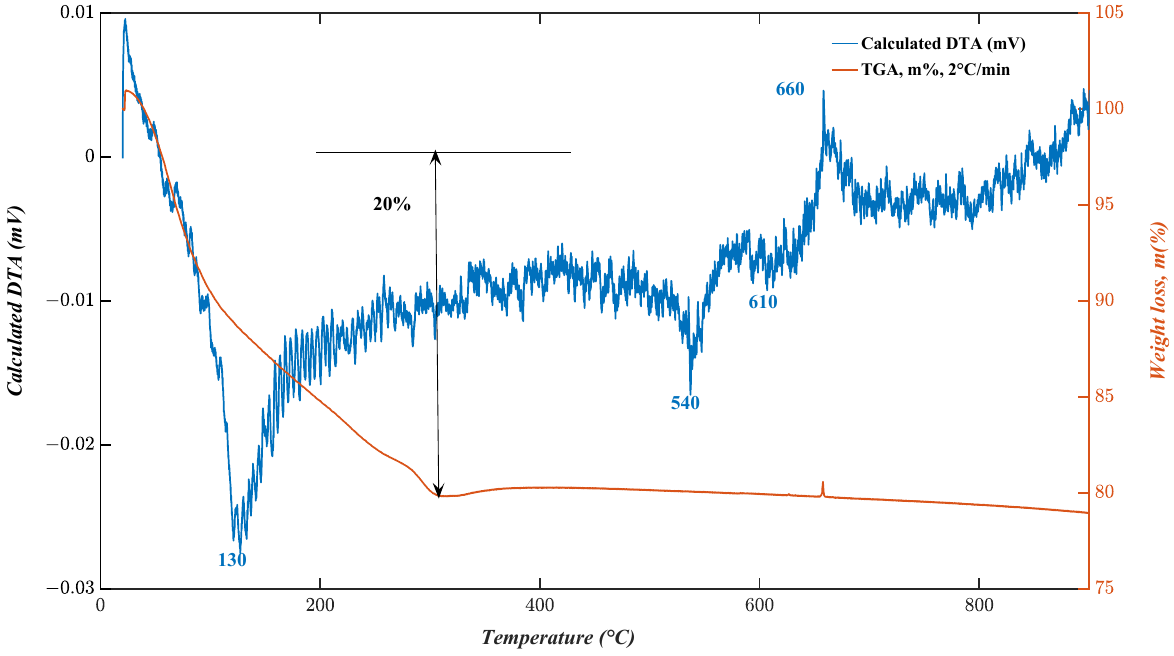
Figure 2. TGA–DTG curves of V 2 O 5 nanosheets.